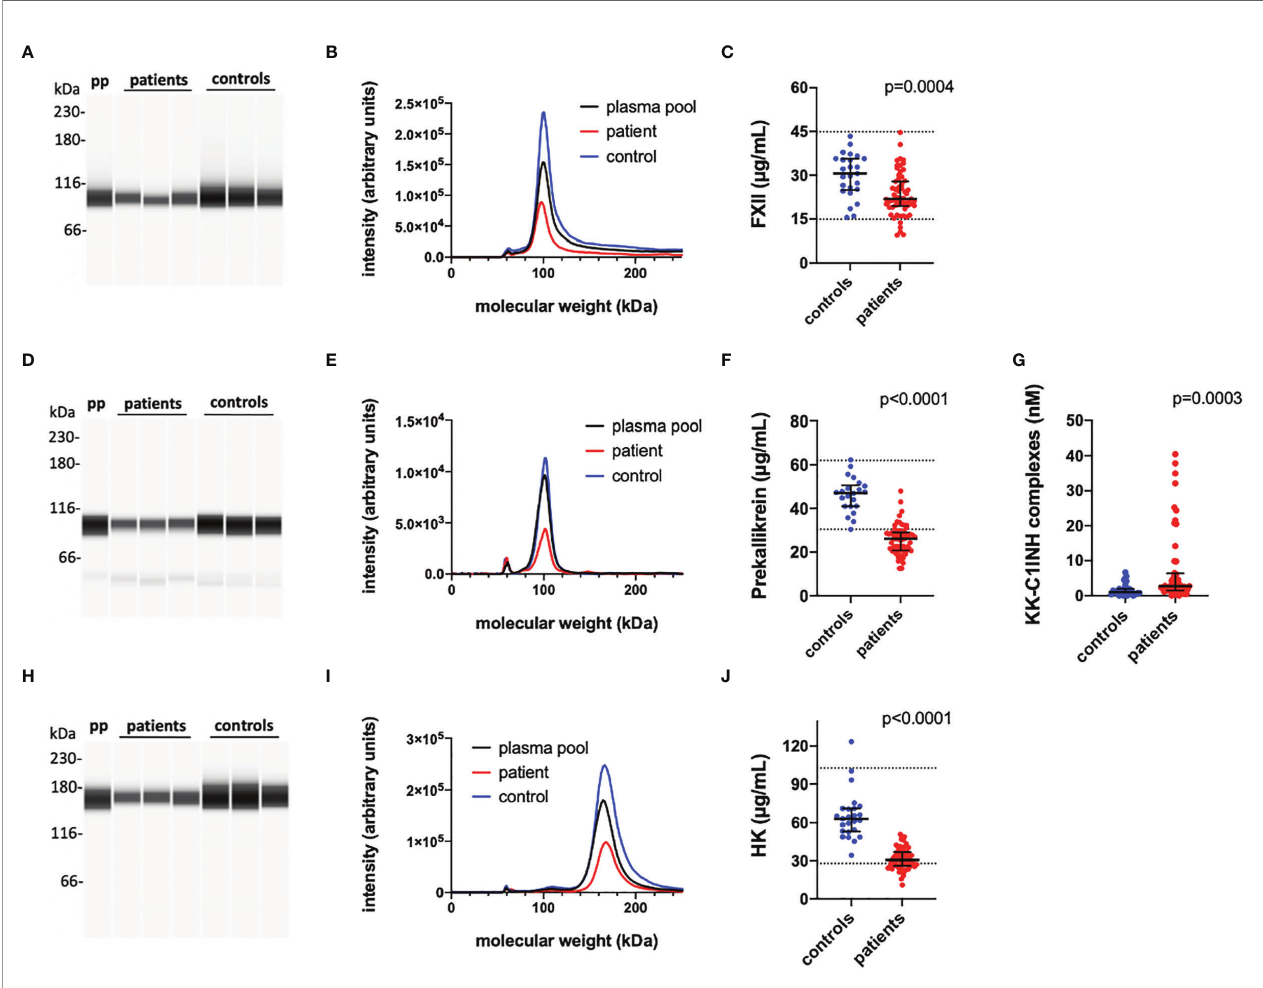
FIGURE 1 | Quanti fi cation of the kallikrein/kinin proteins FXII, prekallikrein and high molecular weight kininogen (HK). The kallikrein/kinin system was activated as re fl ected in high consumption of FXII, prekallikrein, and HK. EDTA plasma from COVID-19 patients and controls were analyzed by capillary electrophoresis under reduced SDS-PAGE-like conditions and the speci fi c kallikrein/kinin proteins detected by speci fi c antibodies against FXII, prekallikrein, and HK, respectively (A , D , H) . The area under the curves of the scan of the chemiluminescence intensities plotted in the panels (B, E, I) were interpreted to their speci fi c concentration by comparing the value for each peak with a standard curve speci fi c for each protein (C , F, J) . The concentration of KK-C1INH complexes were analyzed by sandwich ELISA (panel G ). Representative patients and controls are shown in panels (A, B, D, E, H, I) . The Mann-Whitney U test was used to calculate differences between the groups. For more details see Materials and Methods . pp, plasma pool; KK, kallikrein; C1INH, C1inhibitor; HK, high molecular weight